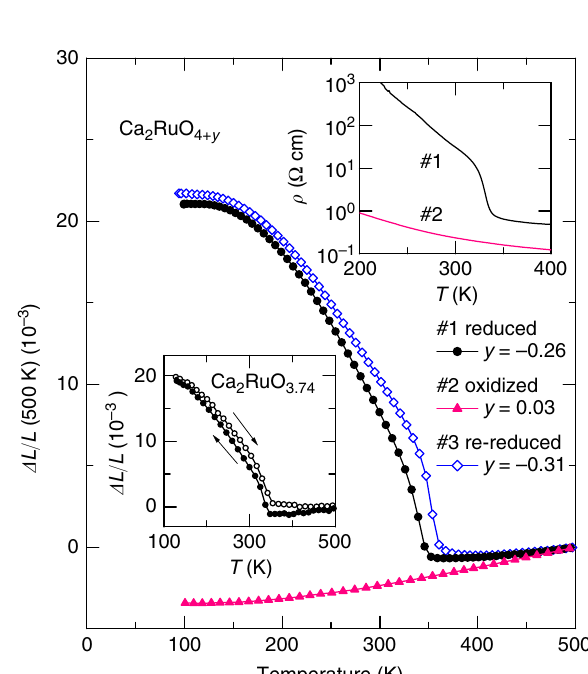
Parameters of materials with phase transition accompanied by large volume contraction on heating, not broadened, are also listed for comparison. *Averaged value when the material is anisotropic. w For NTE region or lower temperature, larger-volume phase. z D, dilatometry; N, neutron diffraction; X, X-ray diffraction. y Successive transitions. ||In warming process.